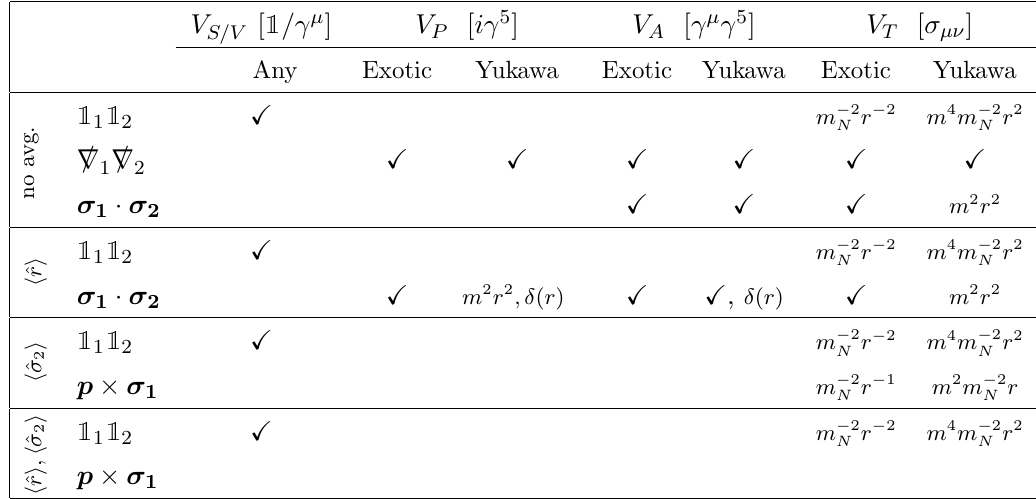
Table 1 . Spin structures, (2.5), generated by S; V; T; P; A nucleon operators in the cases of no av- eraging, the orientation-averaged limit, averaging over N 2 spins, and both the orientation-averaged limit and averaging over N 2 spin. Check marks indicate that the spin structure is generated. Other factors indicate extra suppression depending on the mediator mass, m , and the nucleon mass, m N . Yukawa forces indicate a potential with radial dependence f ( r ) (cid:24) e (cid:0) mr =r . Exotic forces indicate a radial dependence that is not